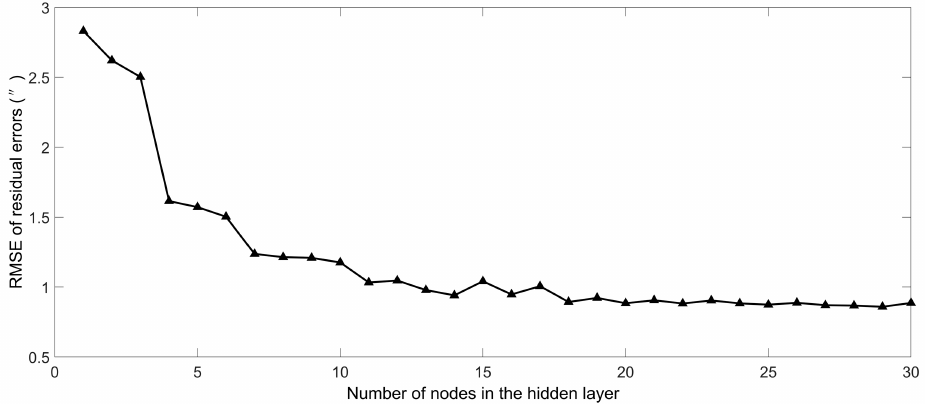
Figure 8. Performance of the BP neural network whose numbers of nodes in the hidden layer is